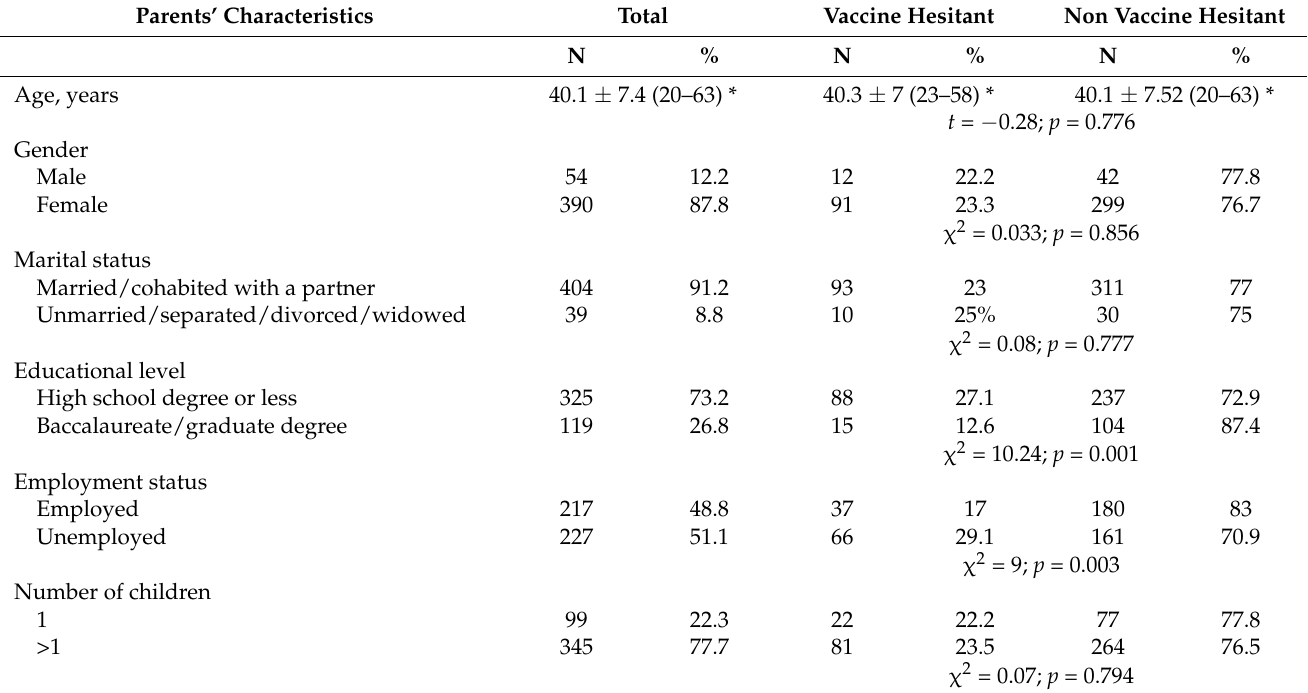
Table 1. Socio-demographic and key characteristics of the study